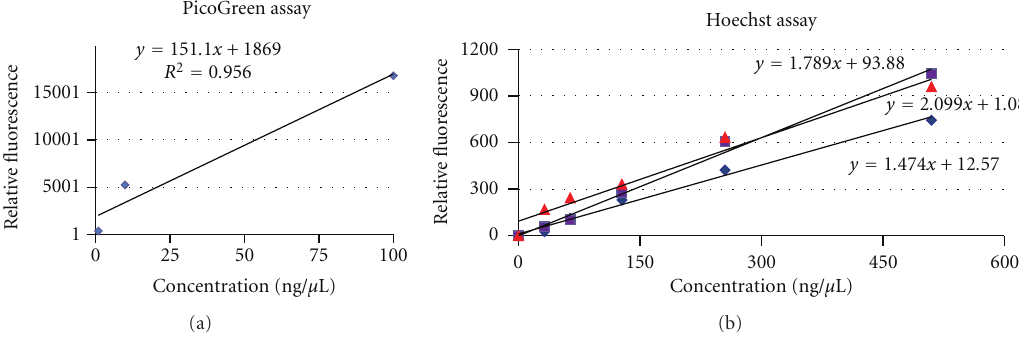
Figure 5: (a) PicoGreen and (b) Hoechst assays for dsDNA, demonstrating the increase in fluorescence as concentration increases in the ng/uL range.